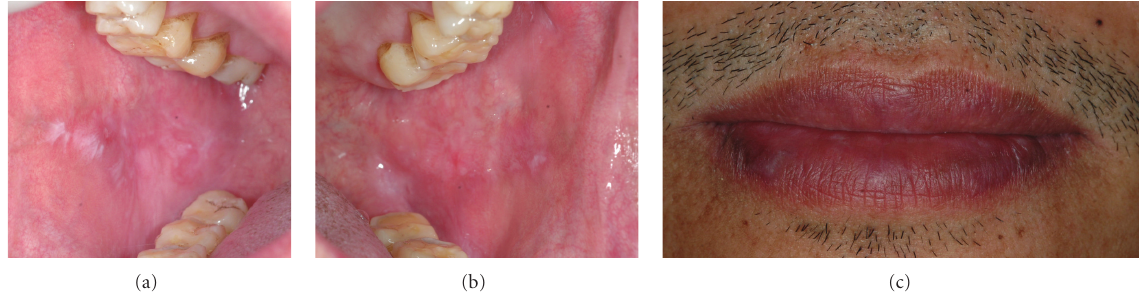
Figure 3: Oral lesions improved at 21 months: (a) right buccal mucosa, score 1, (b) left buccal mucosa, score 0, and (c) the lip, score